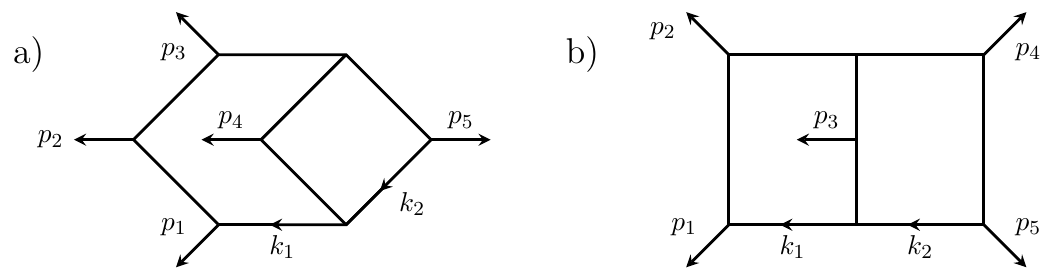
Figure 1 . On the left, with label a), we depict the hexa-box integral family and on the right, with label b), the double pentagon integral